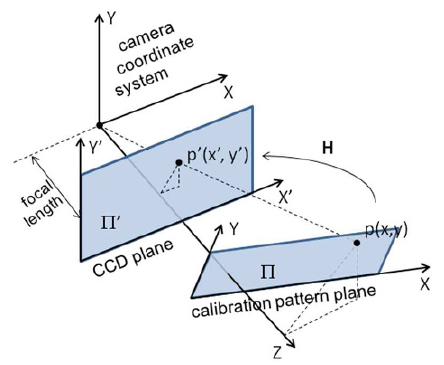
Figure 4. 2D homography.